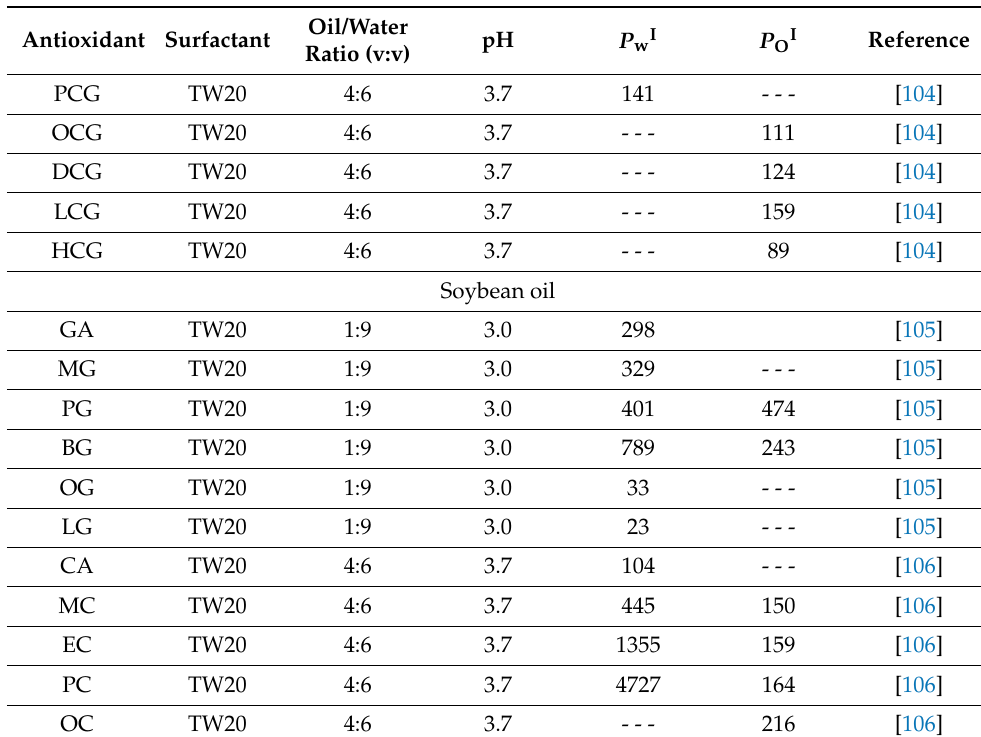
Table 7. Cont. Antioxidant